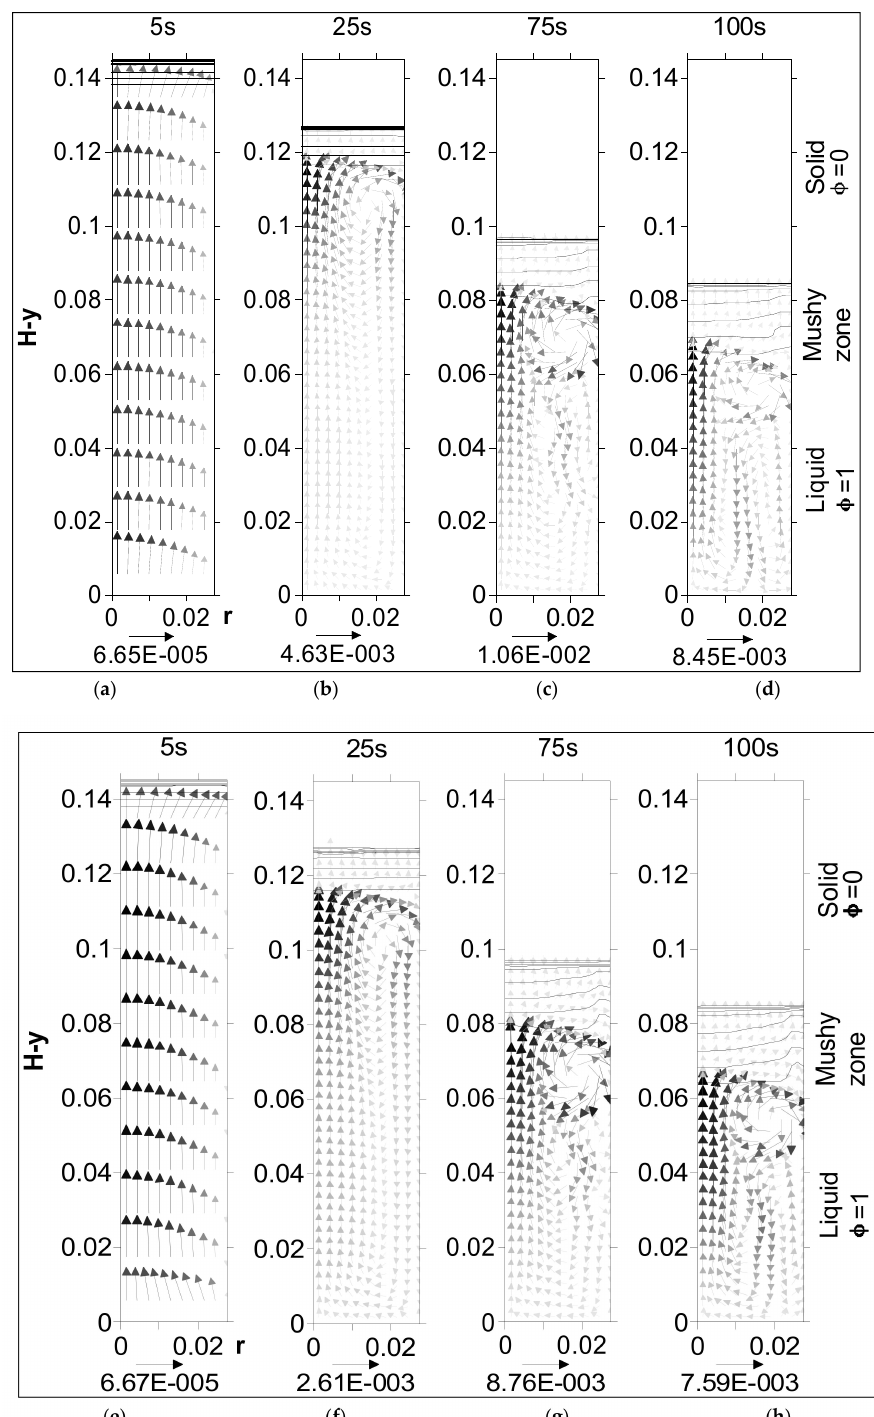
Figure 17. Development of fluid flow velocities (m.s − 1 ) during solidification of Al-wt7%Si alloy. ( a )–( d ) are results for simulation S8 with effect of undercooling for t = 5 s, 25 s, 75 s and 100 s, respectively, and ( e – h ) are results for simulation S7 without the effect of undercooling for t = 5 s, 25 s, 75 s and 100 s, respectively. The magnitudes of maximum velocities are presented at the bottom of ( a – h